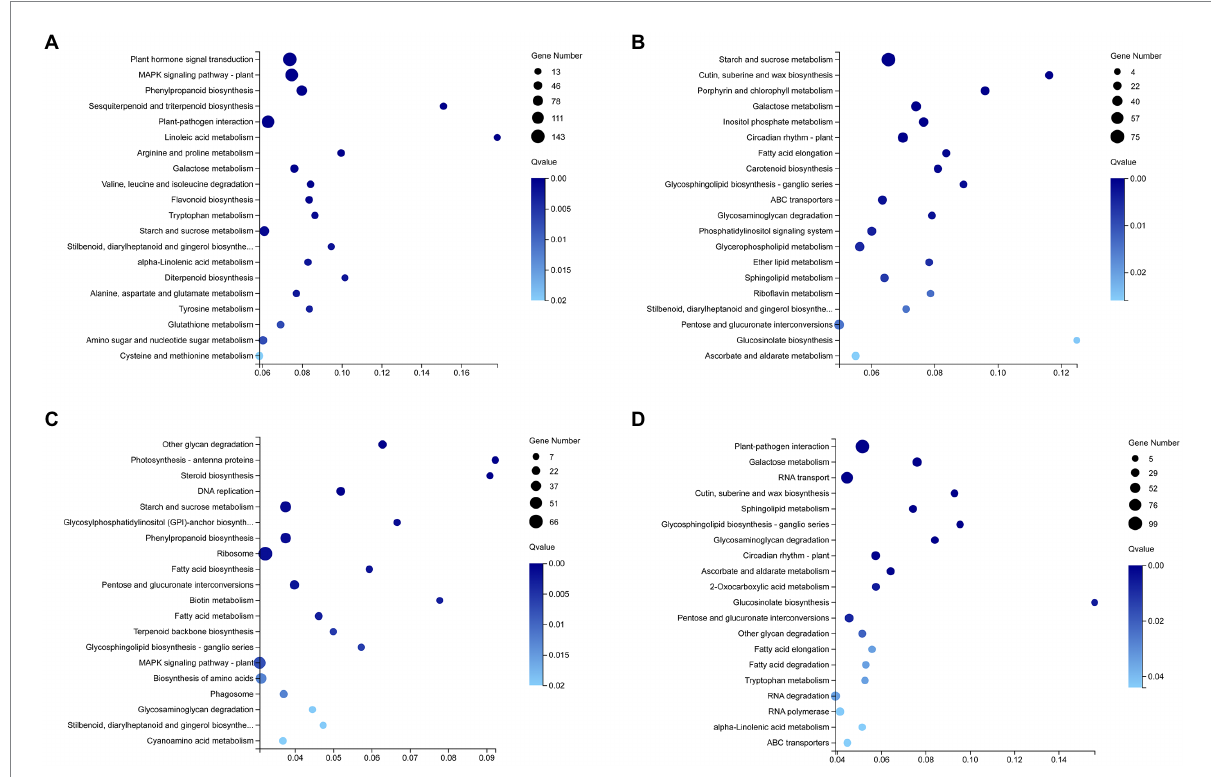
FIGURE 6 KEGG pathway enrichment of different genes in the N vs. N-TMV group and N-TMV vs. WT-TMV group. KEGG pathway enrichment results of upregulated genes (A) and KEGG pathway enrichment results of downregulated genes (B) in the N vs. N-TMV group. KEGG pathway enrichment results of upregulated genes (C) and KEGG pathway enrichment results of downregulated genes (D) in the N-TMV vs. WT-TMV group. For (A) – (D) , the number of enriched DEGs in the pathway is indicated by the circle area, and the circle color represents the range of the corrected p -value.